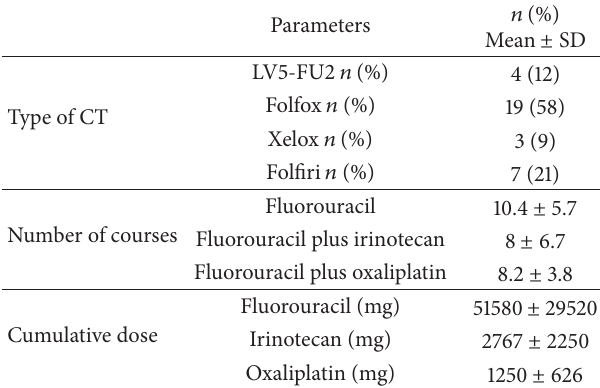
Table2:CharacteristicsofchemotherapyintheChemo+group( 𝑛 = 33